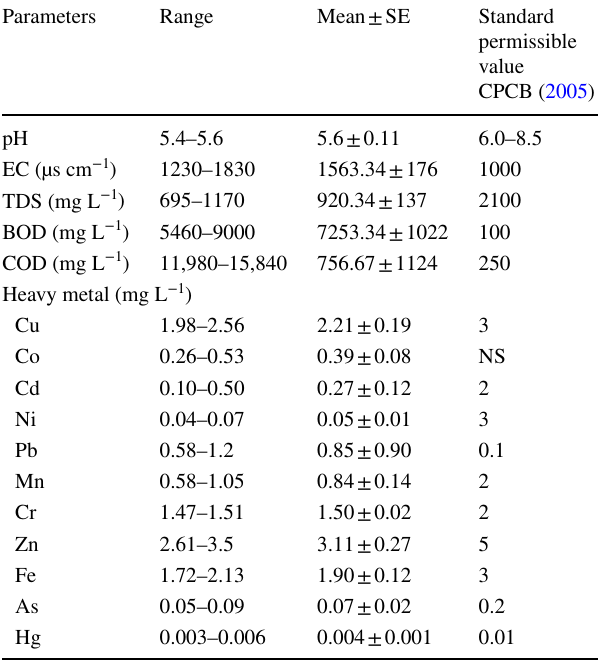
Table 1 Physicochemical characteristics of pharmaceutical